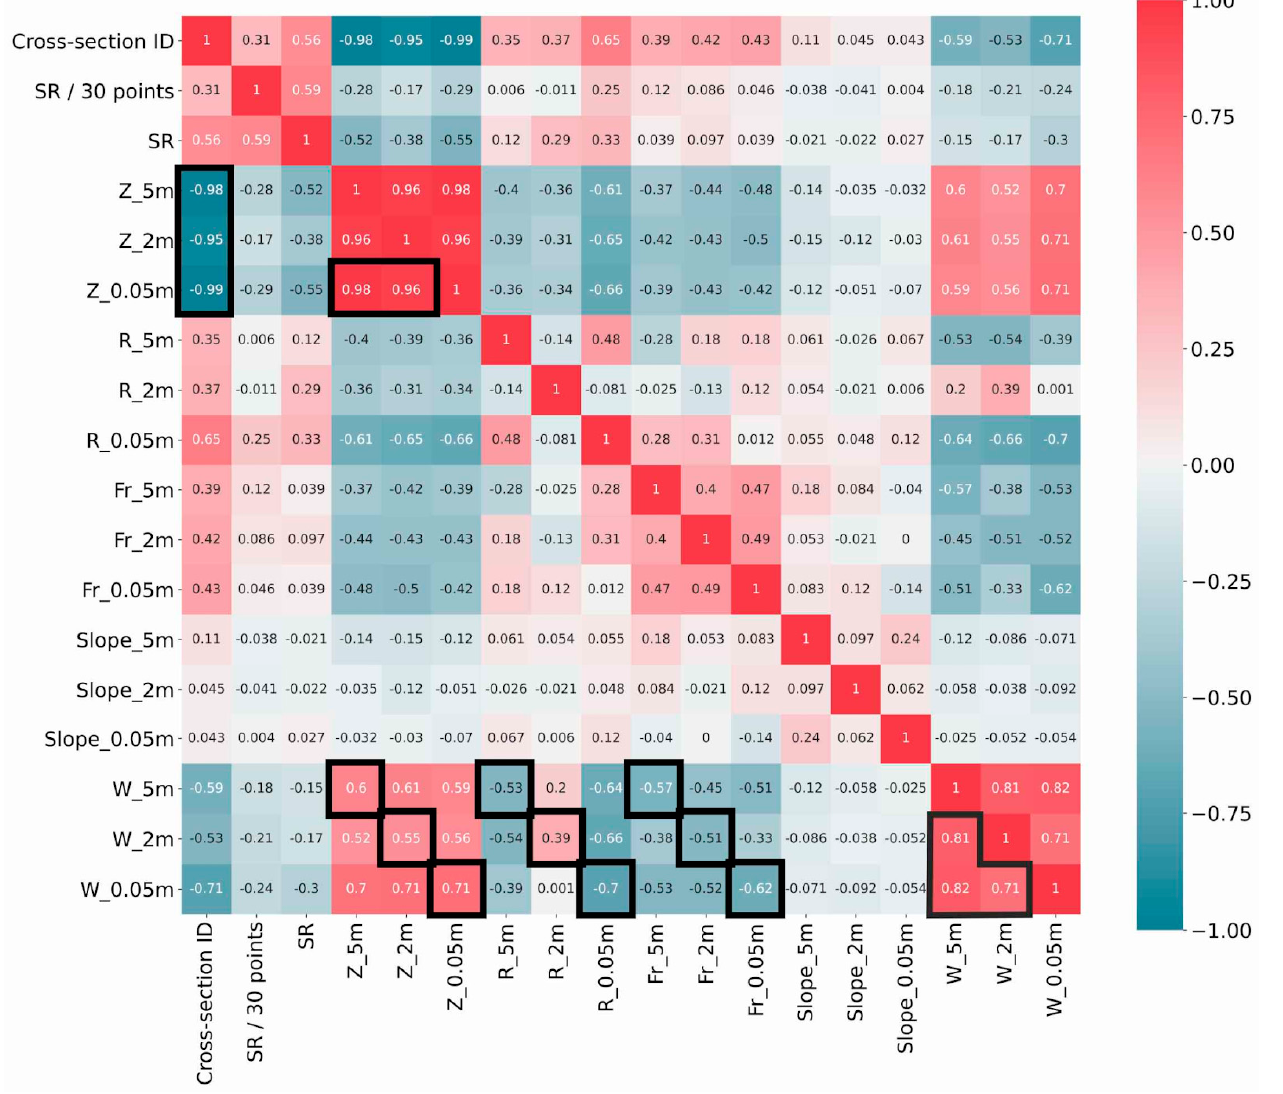
Figure 16. Correlation matrix presenting correlation coefficient values between all involved input data and variables (Sim/DTM-specific or common for all Sims/DTMs) and results (flood extents, flow depths, flow characteristics). Values of interest are highlighted.